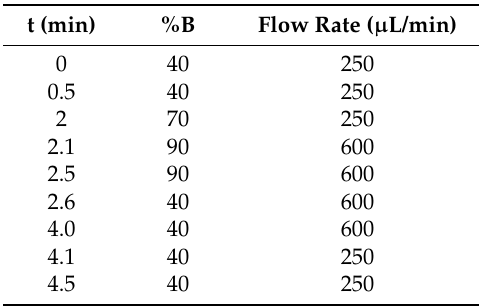
Table 4. The gradient applied for